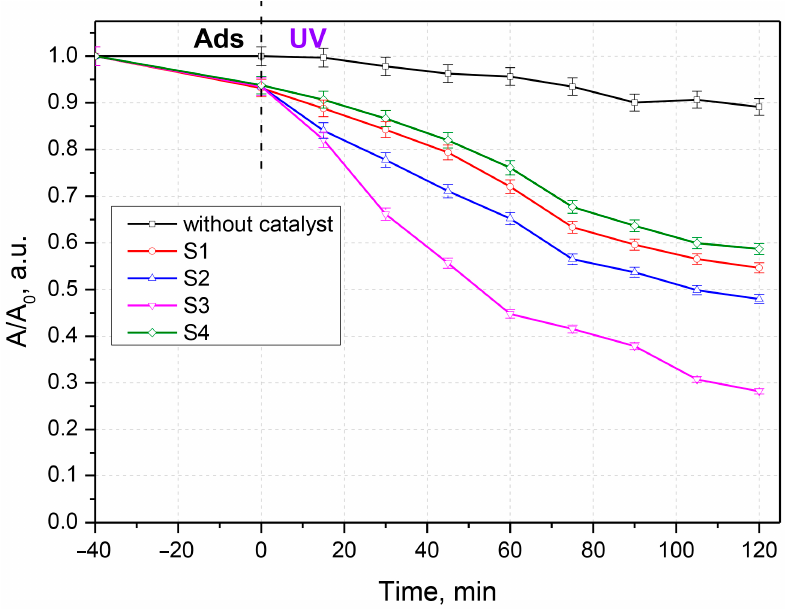
Figure 7. Photocatalytic degradation of the chlortetracycline + ceftriaxone mixture. Oxidation processes of antibiotics take place in hole species (h + ) and O 2 − . When CeO 2 /ZnO —based photocatalytic materials are irradiated with UV rays, pairs of electric charge holes in the valence band and electric charge electrons in the conduction band are formed. The holes immediately react with water molecules or hydroxyl ions and